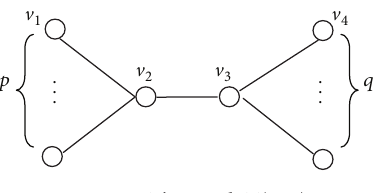
Figure 1: The graph 𝑇(𝑝,𝑞)